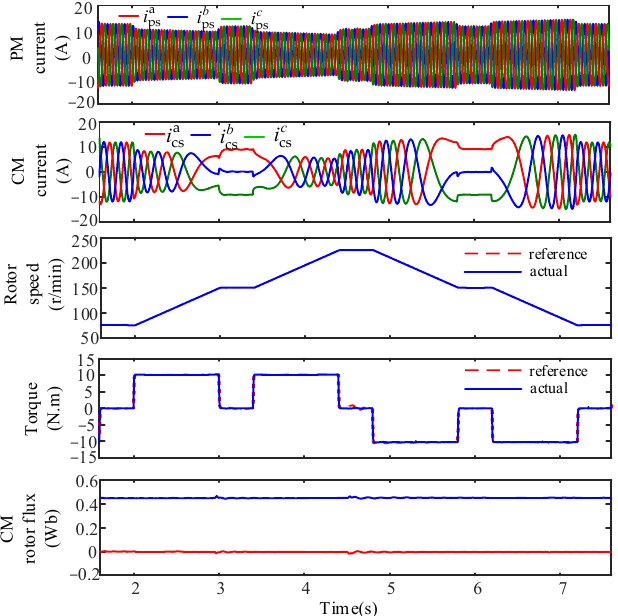
Figure 9. Simulation results of step increase and decrease.